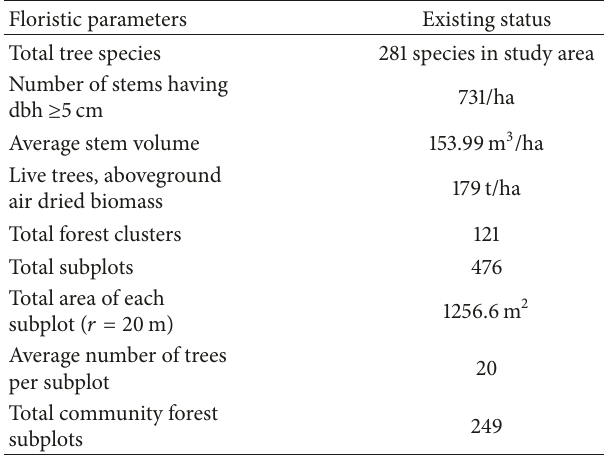
Table 1: Outline of floristic parameters in study